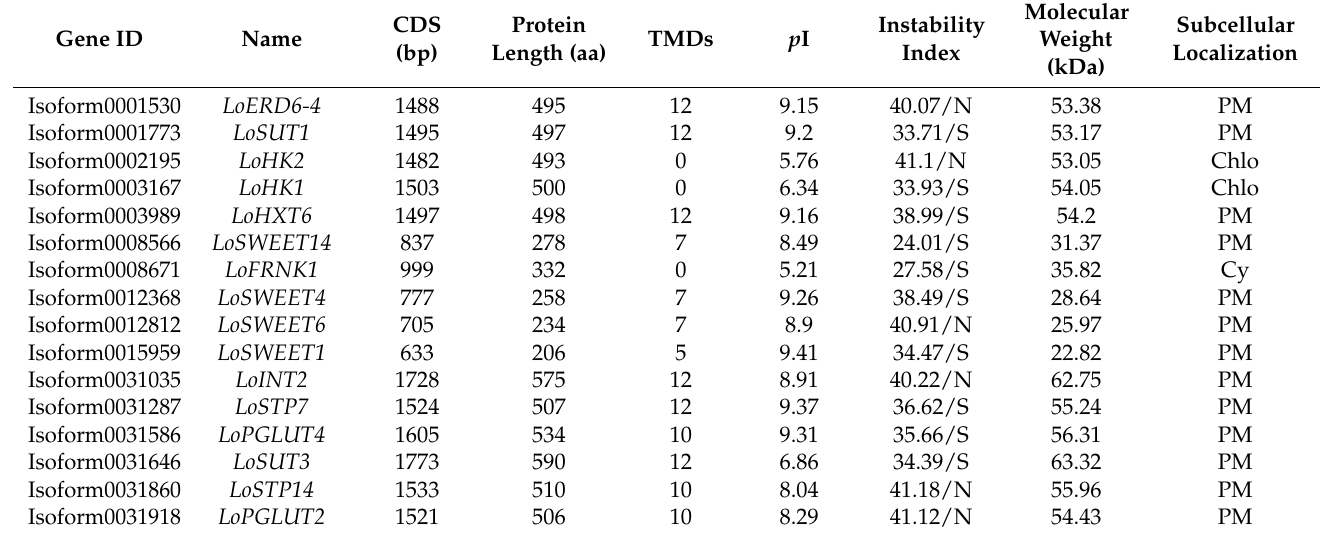
Table 1. Characterization of sugar transporter and metabolism genes in